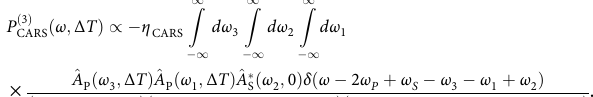
ground state | g 〉 ( π band). In our experiments, c corresponds to stat e , | e , 0 〉 , and the fi rst vibrational excited level, | e , 1 〉 , with respect to the excited electronic stat e | e 〉 ( π * band).